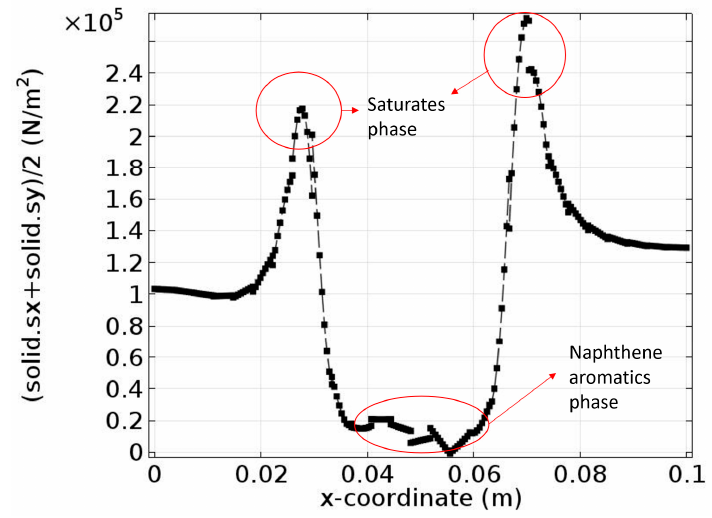
Figure 15. Average stress distribution.